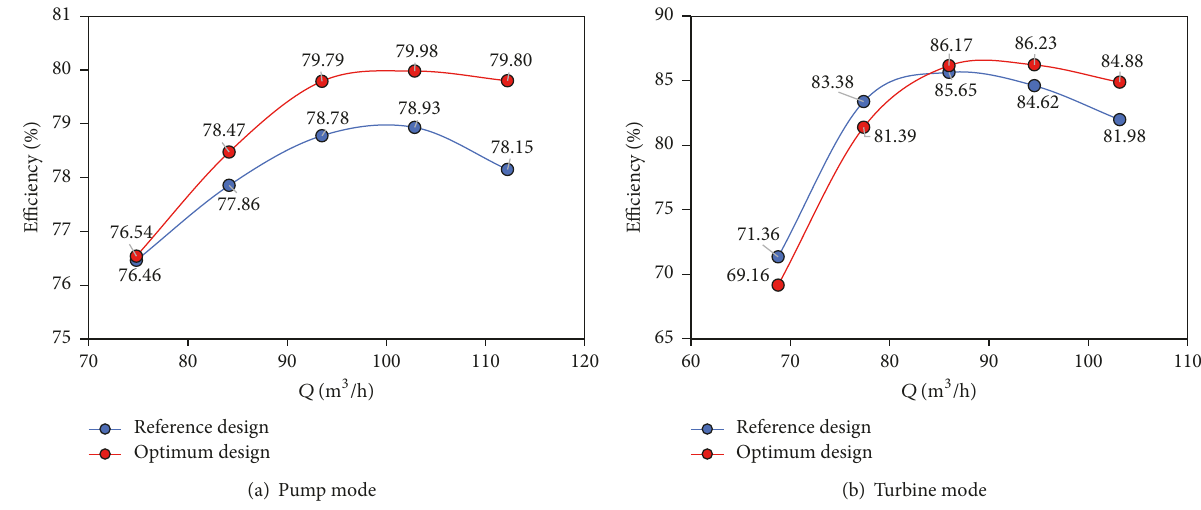
Figure 15: Variation of the pump and turbine mode efficiencies with flow